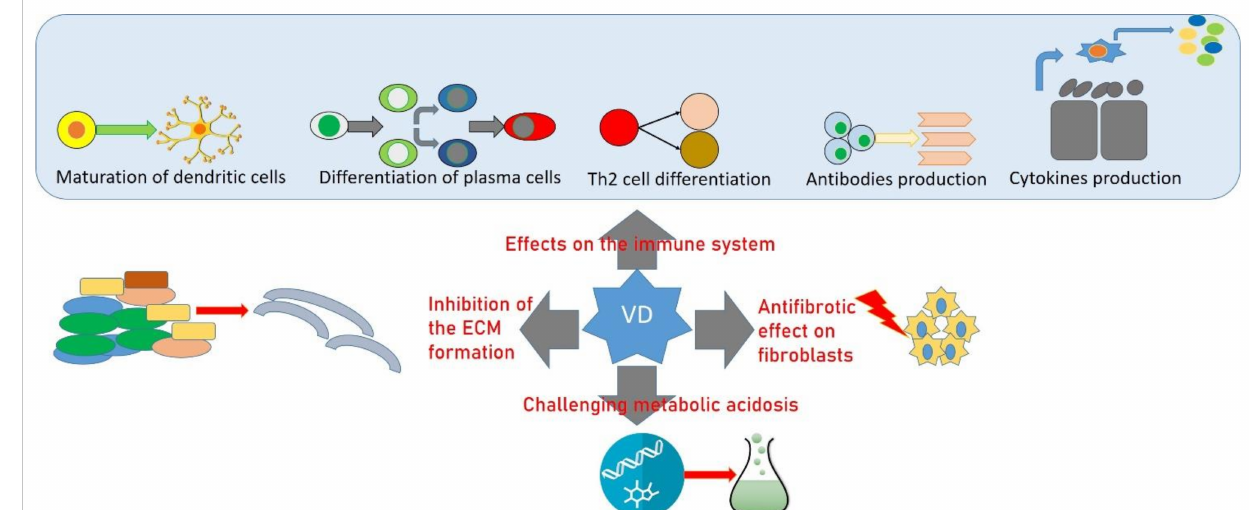
Figure 1. Vitamin D, bone, and autoimmune diseases. ECM: extra cellular matrix; Th2: T helper 2